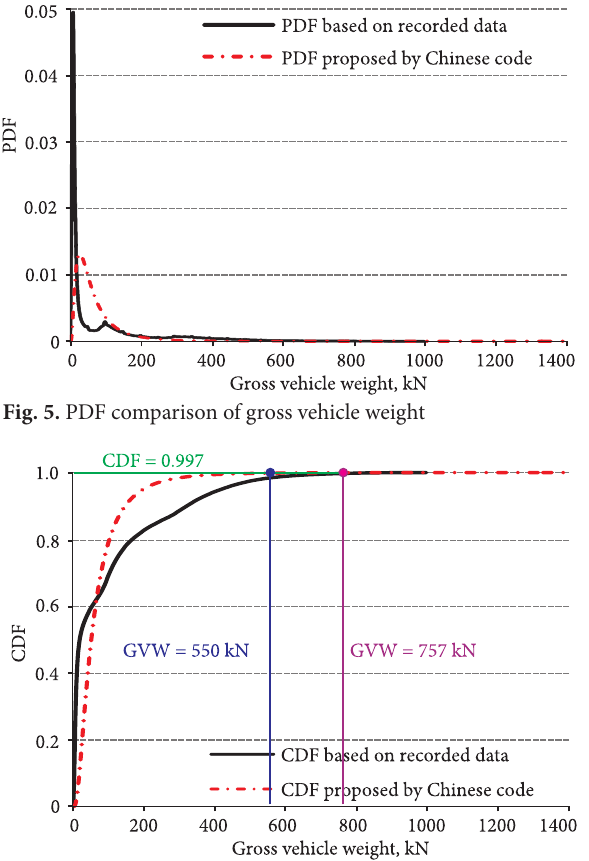
Fig. 6. CDF comparison of gross vehicle weight Table 1. Comparison of gross vehicle weight at different cumulative